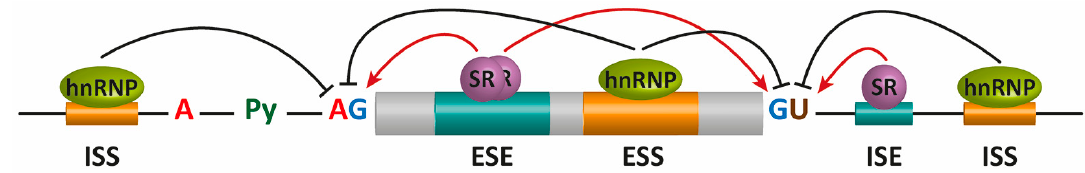
Figure 2. AS regulation by cis elements and trans -acting factors. The core cis sequence elements that define the exon/intron boundaries (5 (cid:48) and 3 (cid:48) splice sites (SS), GU-AG, polypyrimidine (Py) tract, and branch point sequence (BPS)) are poorly conserved. Additional enhancer and silencer elements in exons and in introns (ESE: exonic splicing enhancers; ESI: exonic splicing silencers; ISE: intronic splicing enhancers; ISI: intronic splicing silencers) contribute to the specificity of AS regulation. Trans -acting splicing factors, such as SR family proteins and heterogeneous nuclear ribonucleoprotein particles (hnRNPs), bind to enhancers and silencers and interact with spliceosomal components [18–20]. In general, SR proteins bound to enhancers facilitate exon definition, and hnRNPs inhibit this process.